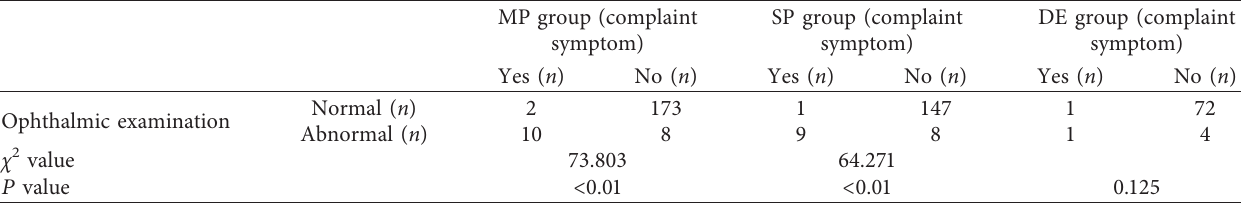
Table 4: Consistency comparison between the complaint symptom and the ophthalmic examination (Fisher exact probability).